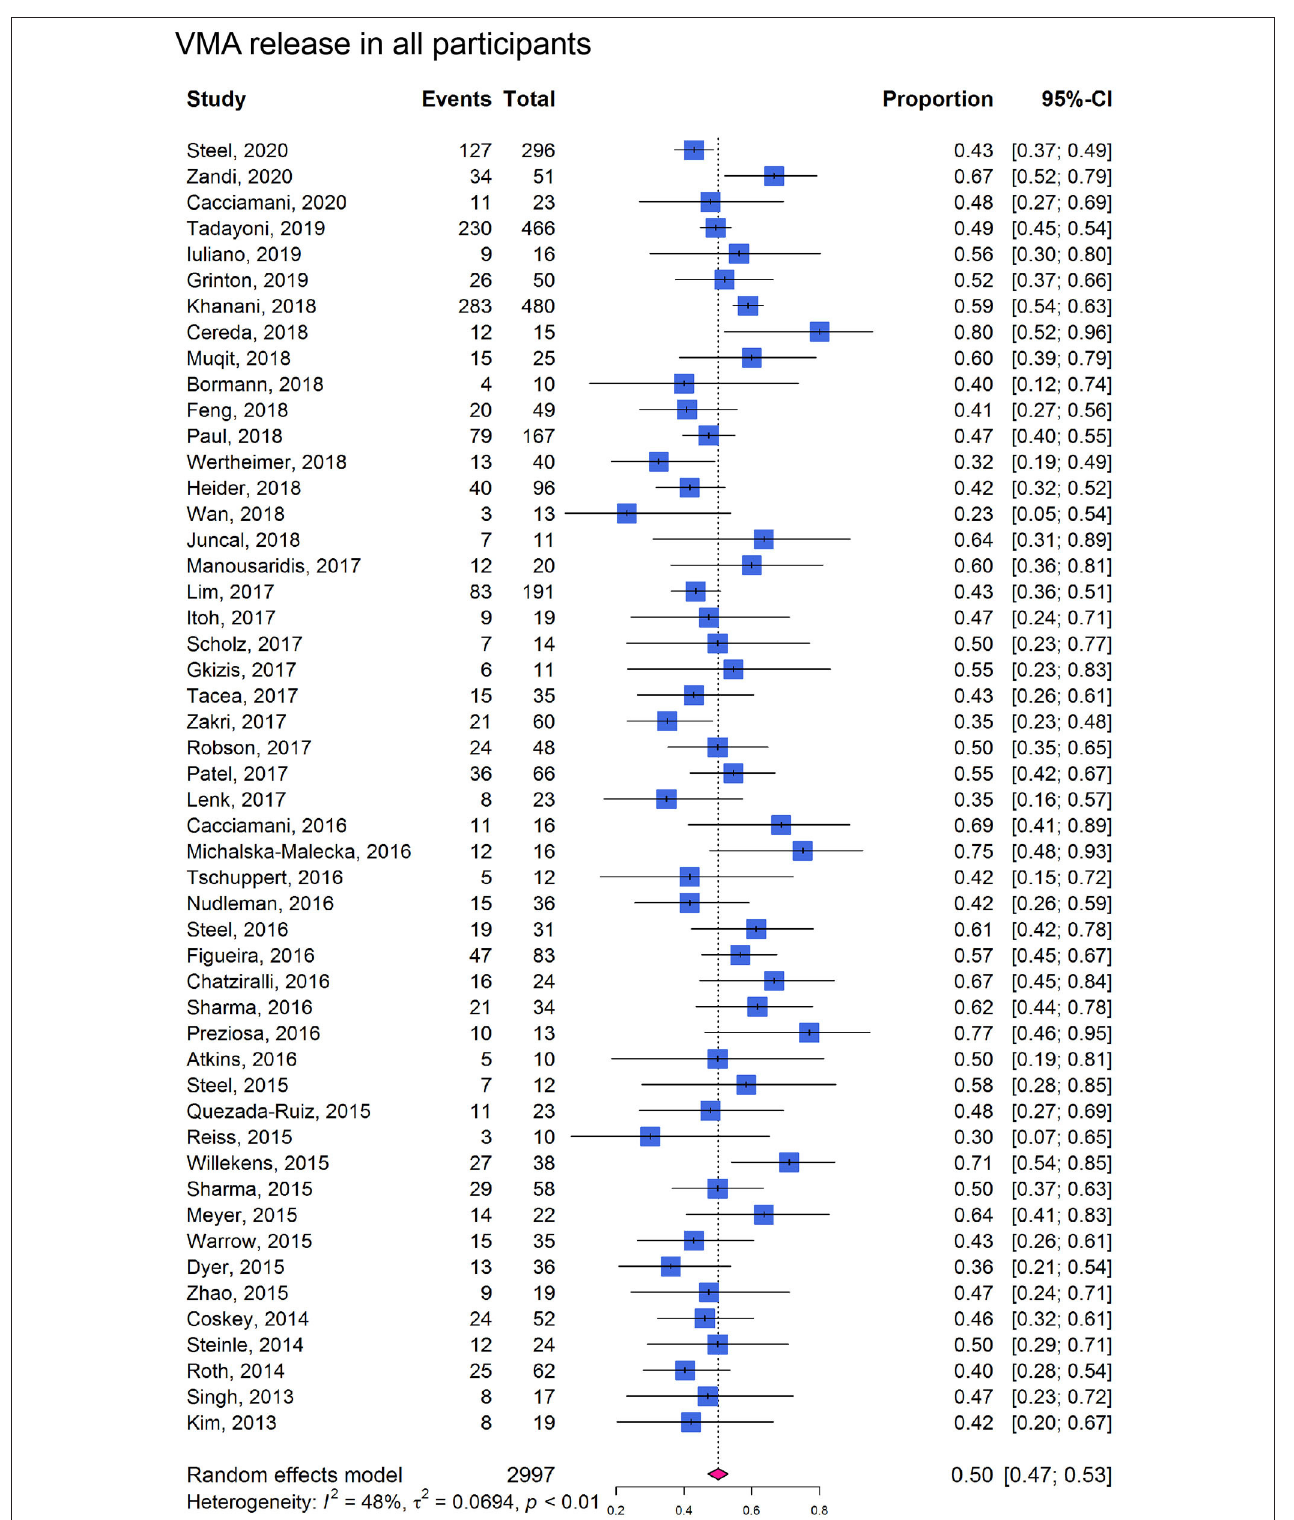
FIGURE 3 | Forest plots of proportion of VMA release in participants receiving ocriplasmin therapy in included cohort studies.